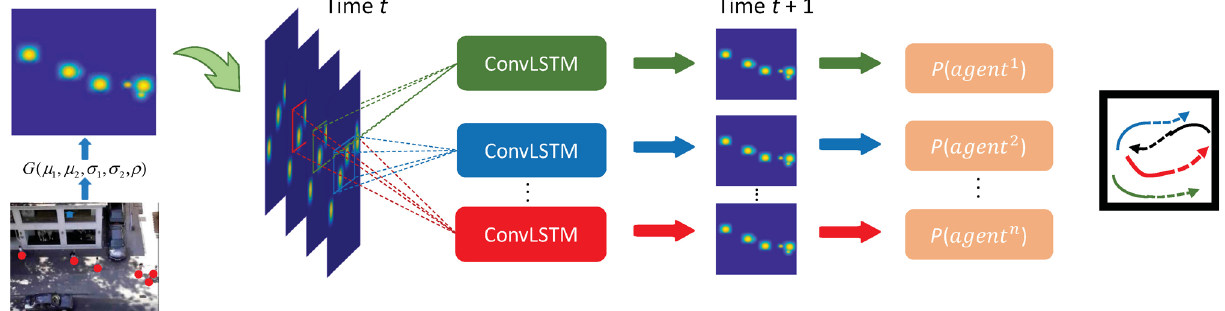
Fig. 3 Overview of the social probability method. We use a separate ConvLSTM network for each trajectory in the scene. Inputs and outputs of the model are both trajectory distributions. The trajectory distribution is mapped from fixed point coordinates; a single trajectory distribution at time t contains all pedestrians’ trajectory information. The ConvLSTM network consists of a convolutional layer and gate modules, and has the ability to learn spatio-temporal features. In the prediction stage, the output of our model is again in the form of trajectory distributions, and trajectory coordinates can be obtained by sampling